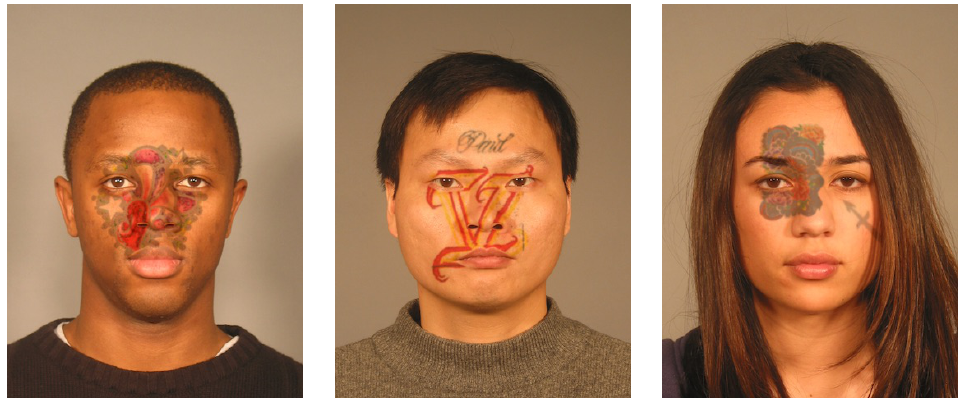
Figure 8. Examples of facial images where parts of one or more tattoos have been cut out. Black ink tends to change in colour slightly over time due to the pigment used in black ink. Therefore, for colour adjustment, all pixels of a tattoo which are similar to pure black are selected and changed to simulate different colours of grey, green, and blue, which causes black tattoos to appear differently for different facial images. The colour adjustments of black pixels are determined per tattoo, and as such slight variations can occur between different tattoos in the same facial image. Examples are given in Figure 9.